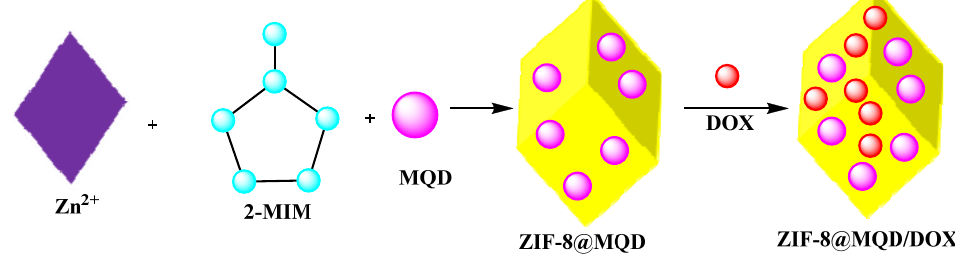
Figure 8. The preparative process of MXene quantum dot/ZIF-based systems for anticancer drug delivery [97].